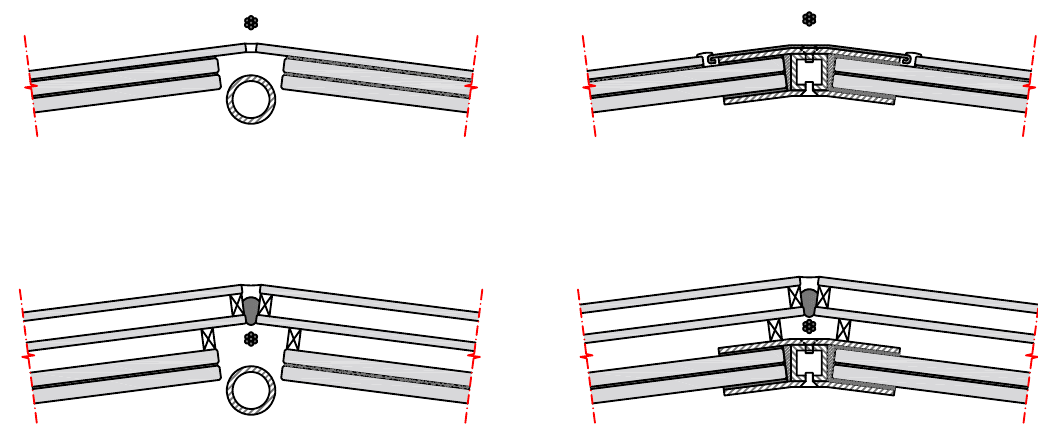
Fig. 2 Edge detail with structural laminated glass package, hollow rod as reinforcement (with different restraint degrees) and spiral cable: (top) with sacrificial glass layer; (bottom) with